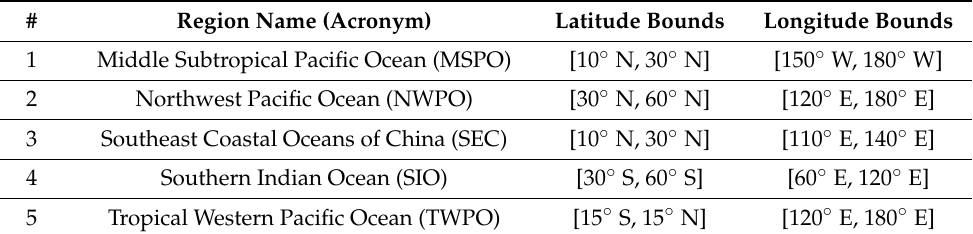
Table 1. Five rectangle regions selected for the analysis of multiple-variables linear regression and their latitude and longitude